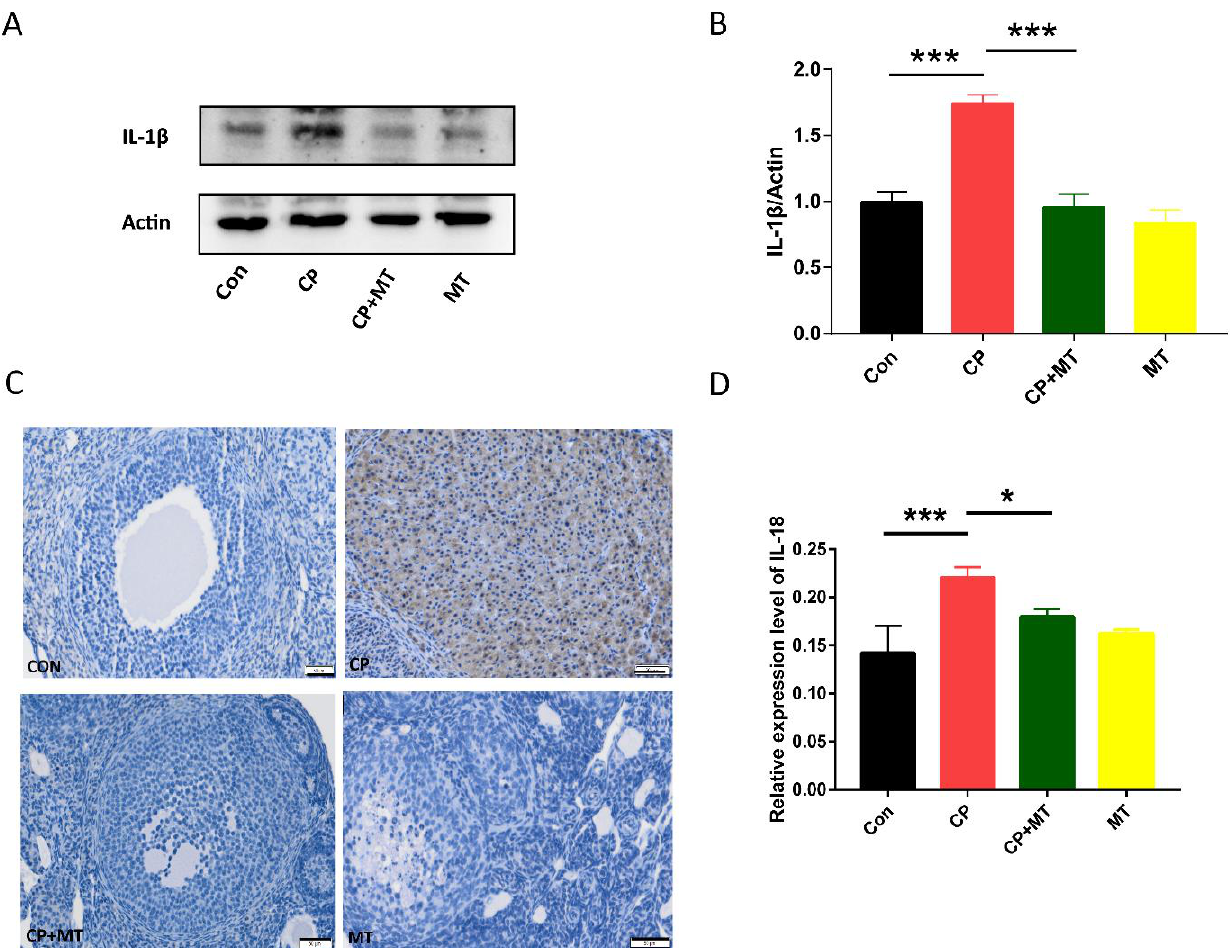
Figure 3. MT inhibited CP-induced ovarian inflammation. ( A ) Western blot analysis for IL- 1β expression in the Con, CP, CP + MT, and MT group ( n = 3). Actin was used as an internal control to measure the quality of protein. ( B ) Relative intensity of IL- 1β was assessed by densitometry. *** significant difference ( p < 0.001). ( C ) Images depicting IL-18 expression in ovaries by Immunohistochemistry in Con, CP, CP + MT, and MT groups. Bar = 200 µ m. ( D ) Relative intensity of IL-18 was assessed by densitometry. *** significant difference ( p < 0.001); * significant difference ( p <